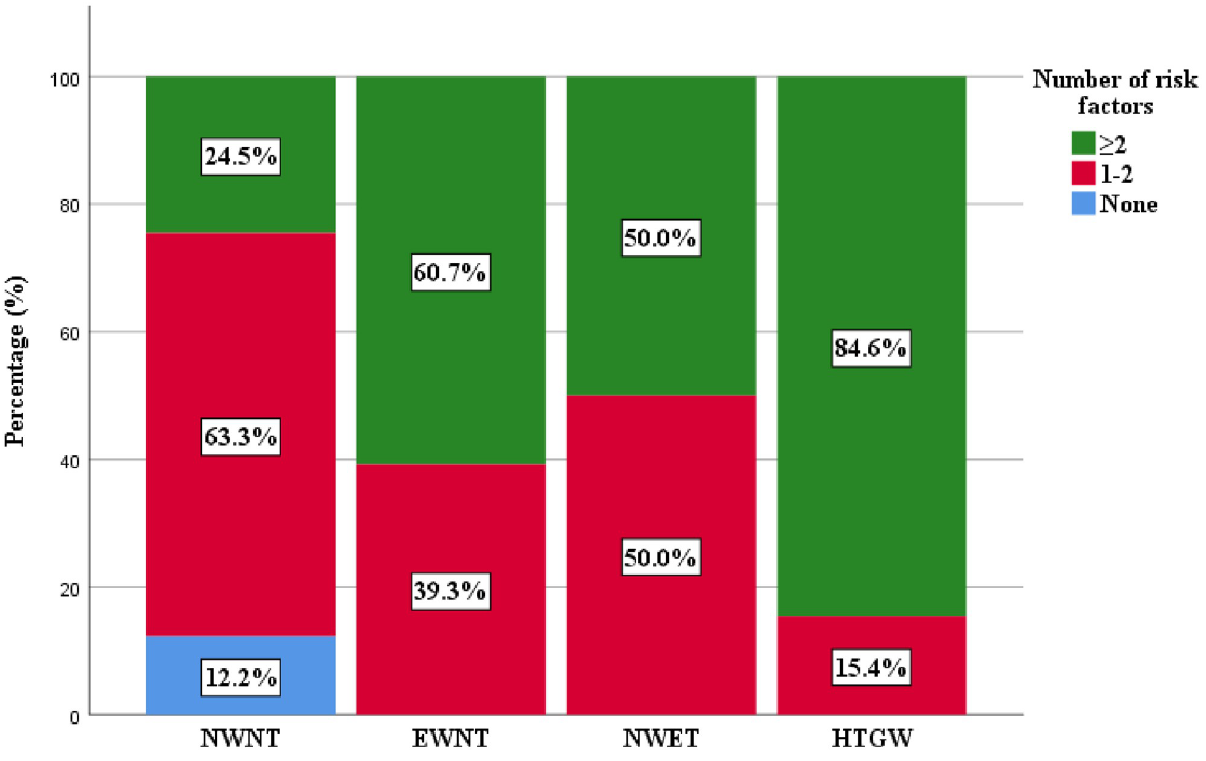
Fig 4. The frequency of the CVD risk factors in the triglyceridemic-waist phenotypes.